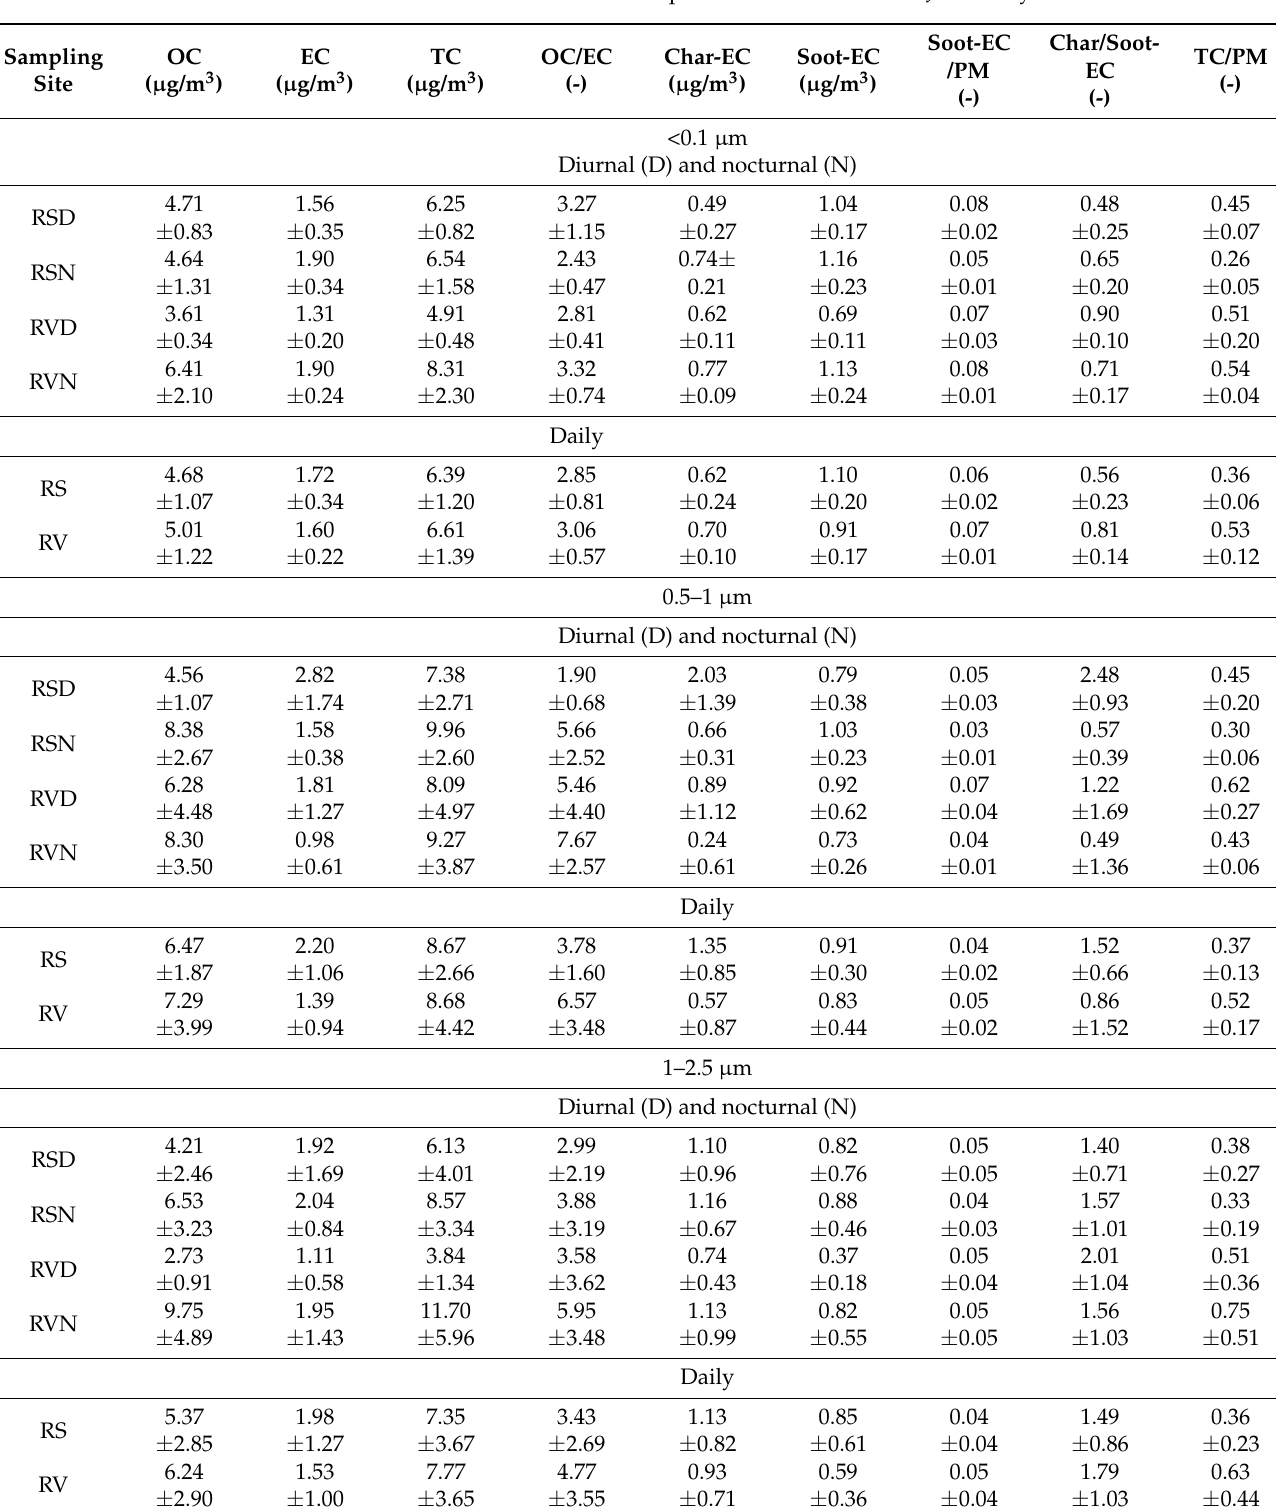
Table 2. Particle-bound carbonaceous components and their ratio in Jambi